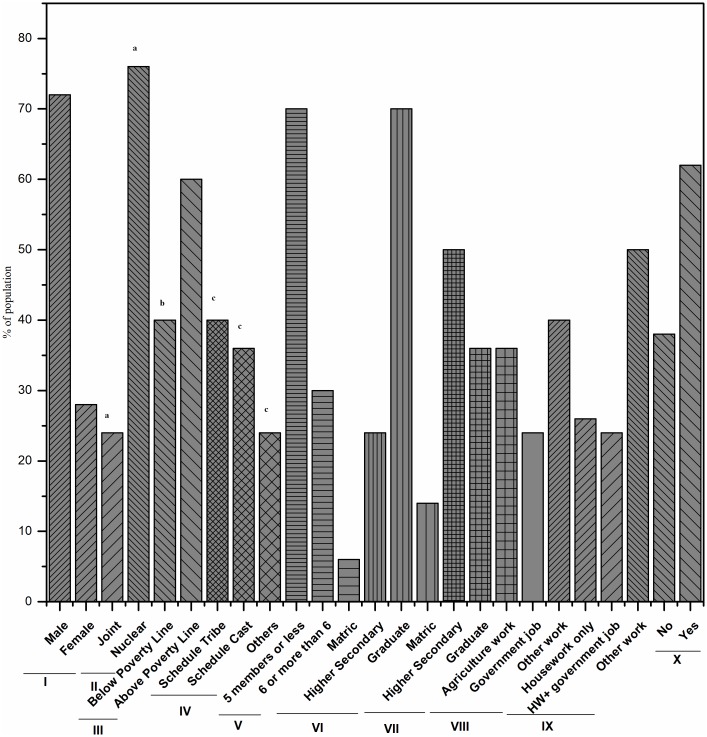
Demographic details of community participants.Demographic details of community participants and their families are represented as a percentage of the population against the total population (N = 550). a: ‘Nuclear family’ referred to those families having only parents and children living in one household premises and ‘Joint family’ referred to the families having parents, children and their relatives living in one household premises; b = Family below poverty line refers to those families having possession of “Below Poverty Line (BPL)’ card issued by Government of India (GOI); c = Scheduled castes, backward castes and scheduled tribes are special status groups of socially and economically deprived classes of people as defined by the GOI; I: Gender of Children; II: Family type; III: Economic status; IV: Caste; V: Number of family members; VI: Paternal education; VII: Maternal education; VIII: Maternal occupation; IX: Antibiotics used last month.